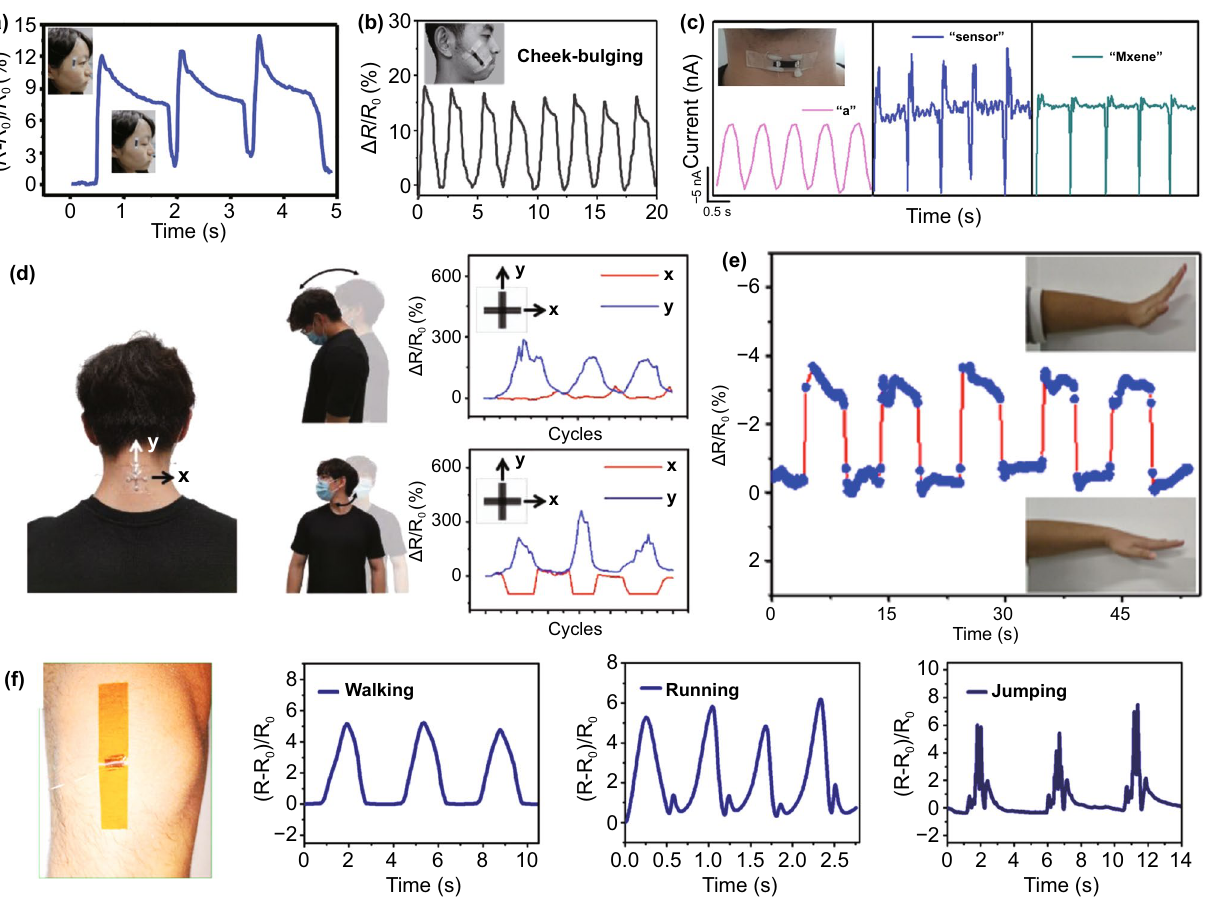
Fig. 9 a The monitoring of the blinking by attaching a strain sensor to the corner of one eye [90]. Copyright © 2016 Wiley–VCH. b Detection of the signals generated by cheek bulking [141]. Copyright © 2017 Wiley–VCH. c Real-time recording and recognition of speaking different words [193]. Copyright © 2019 Wiley–VCH. d Detection of neck movements through a multidirectional strain sensor [195]. Copyright © 2019 Wiley–VCH. e Monitoring the motion of wrist bending by attaching the miniaturized strain sensor to the wrist [199]. Copyright © 2020 Ameri- can Chemical Society. f The detections of walking, running, and jumping by mounting a strain sensor on the knee surface [201]. Copyright